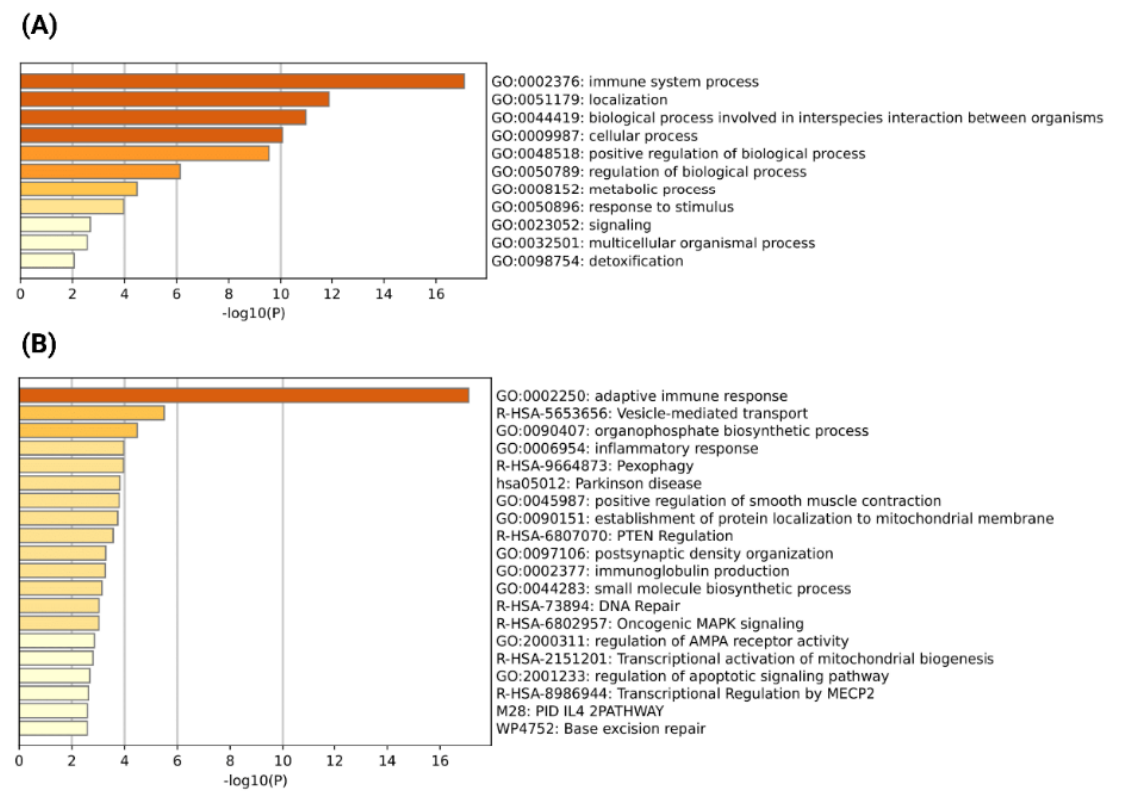
Figure 5. ( A ) GO biological process enrichment analysis of the parental genes of common chimeric transcripts associated with multiple severe respiratory viral infections and severe COVID-19; ( B ) Top-most enriched processes and pathways of the parental genes of common chimeric transcripts associated with multiple severe respiratory viral infections and severe COVID-19 detected by Metascape ( p -value cutoff < 0.05).